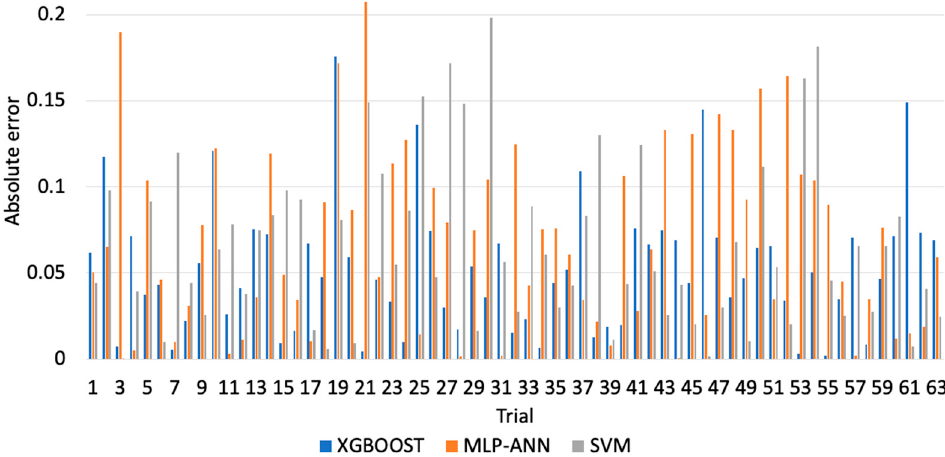
Figure 7. Comparison of errors in predicting flank wear of the cast iron workpiece.